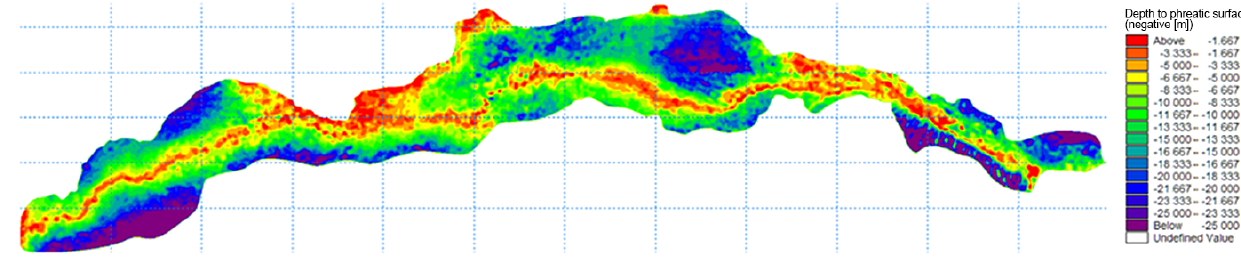
Figure 5. Simulated groundwater levels along the Tarim. Table 2. ESS Indicators.